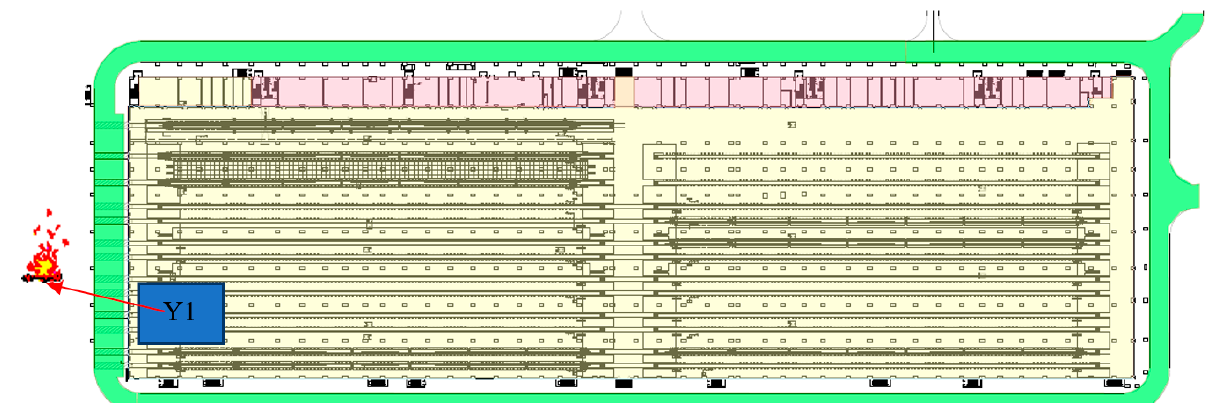
Figure 10. Location map of fire scene using library